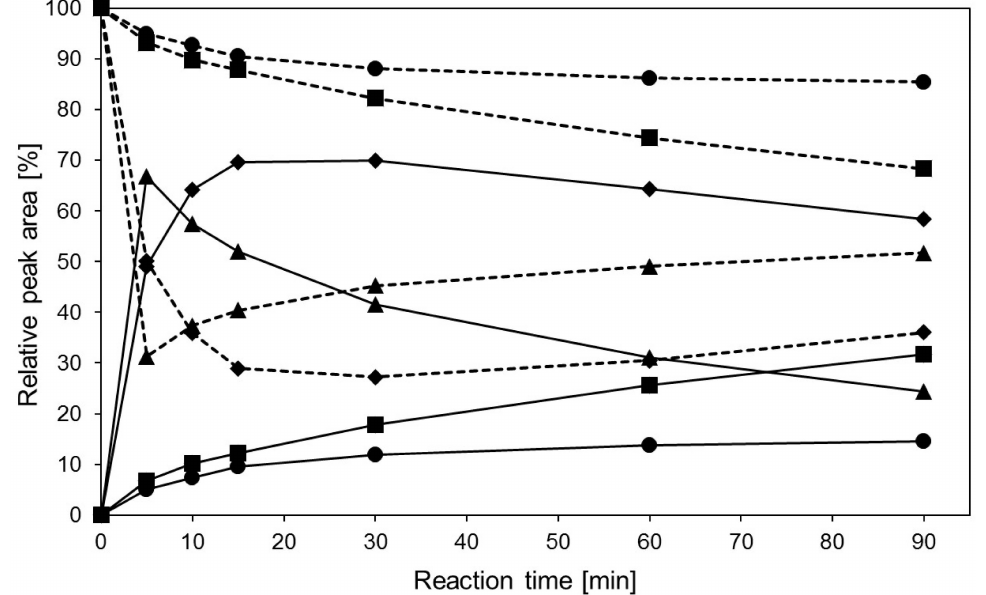
Figure 3. Transgalactosylation reaction with hyperthermophilic β -glycosidase from Pyrococcus under MWI and TH starting from 10 mM GlcNAc-linker- t Boc. Analytical HPLC were used for monitoring acceptor substrate (GlcNAc-linker- t Boc, dashed lines) and the main product (Gal β (1,4)GlcNAc-linker- t Boc, solid lines) at 254 nm. Experimental conditions: 100 W MWI ( (cid:4) ) with an average temperature of ~20 ˝ C, 300 W MWI ( (cid:7) ) with an average temperature of ~30 ˝ C, 85 ˝ C TH ( (cid:78) ) and 20 ˝ C TH ( ). The reaction mixture (1 mL) contained 12 U enzyme, 10 mM GlcNAc-linker- t Boc and 600 mM lactose in 25 mM citrate-phosphate buffer pH 5.5. The measured data with standard deviations are listed in Table